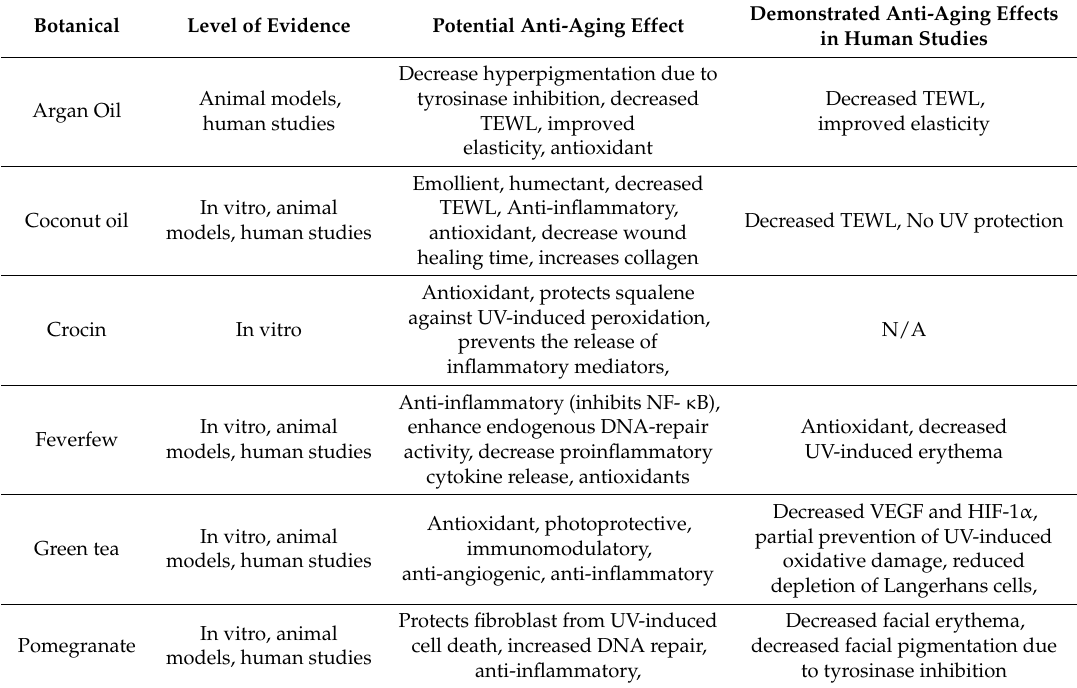
Table 1. Level of studies supporting anti-aging effect of listed